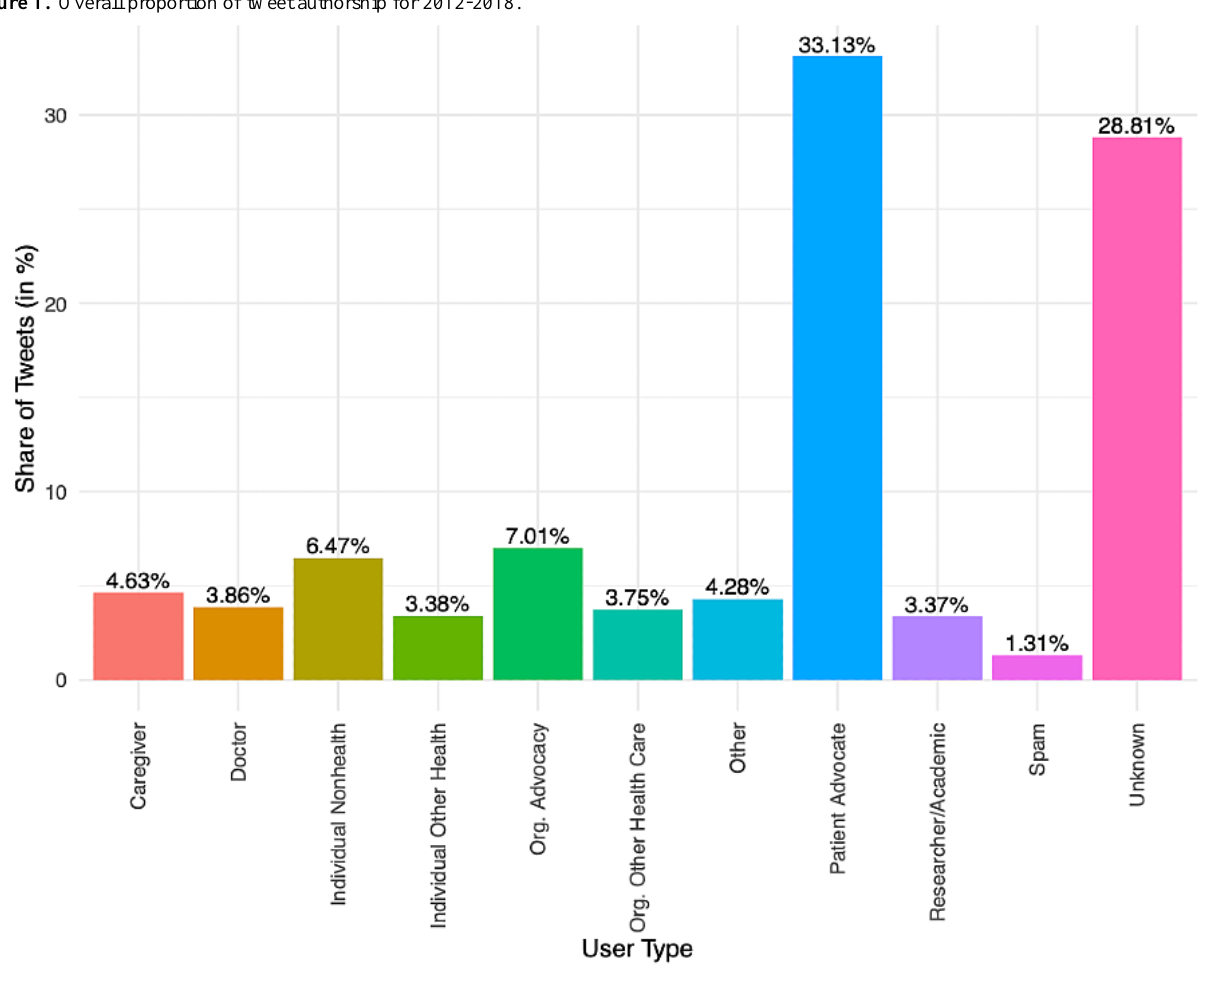
Figure 1. Overall proportion of tweet authorship for